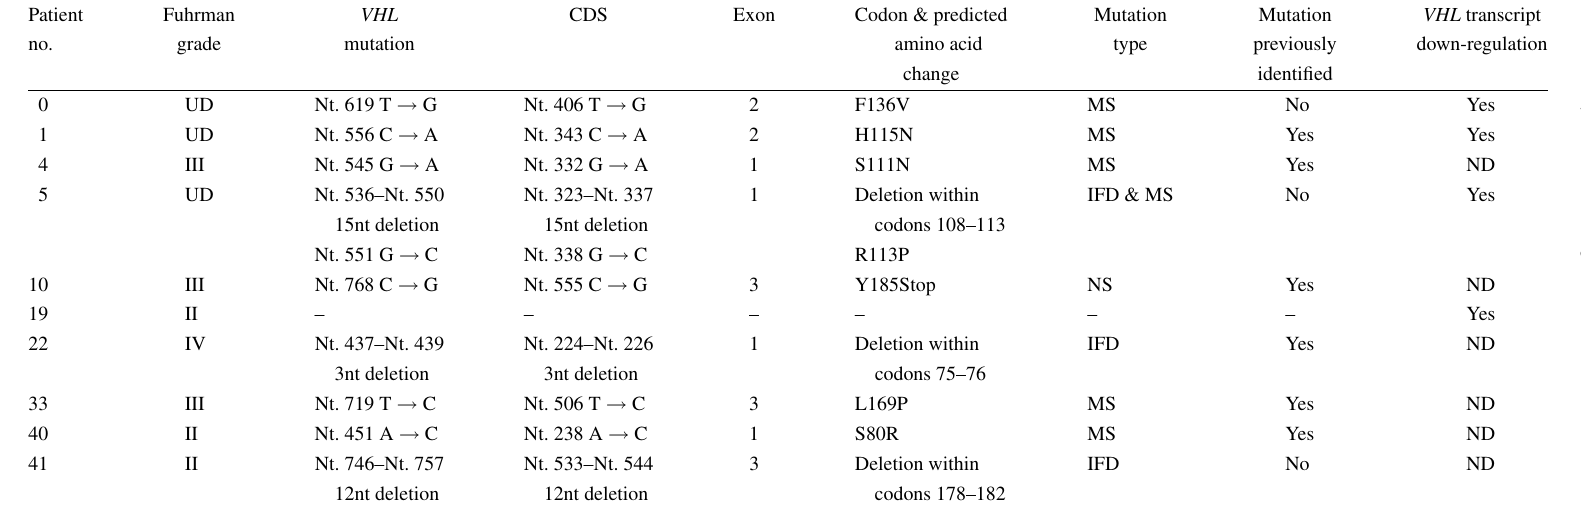
Summary of VHL genetic alterations identified in sporadic CCRCC